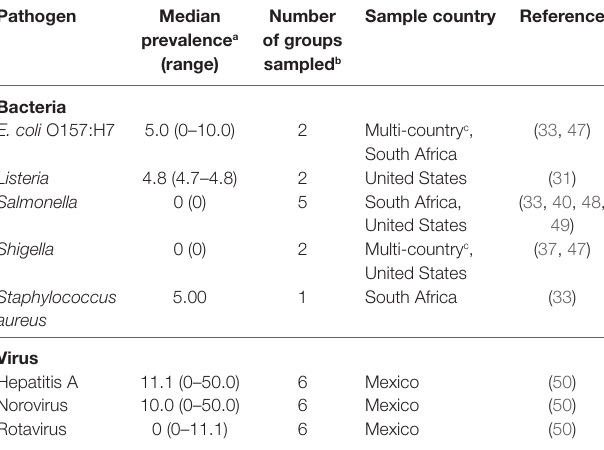
tabLe 3 | Pathogen prevalence on produce from packing facilities by pathogen